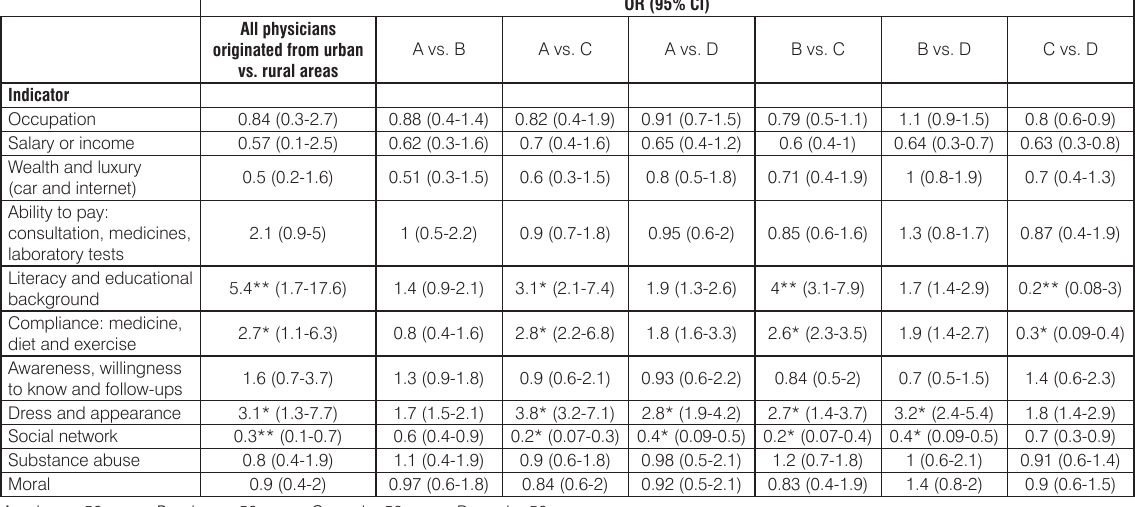
Table 3. Importance of socioeconomic indicator as determinant of the patient’s socioeconomic